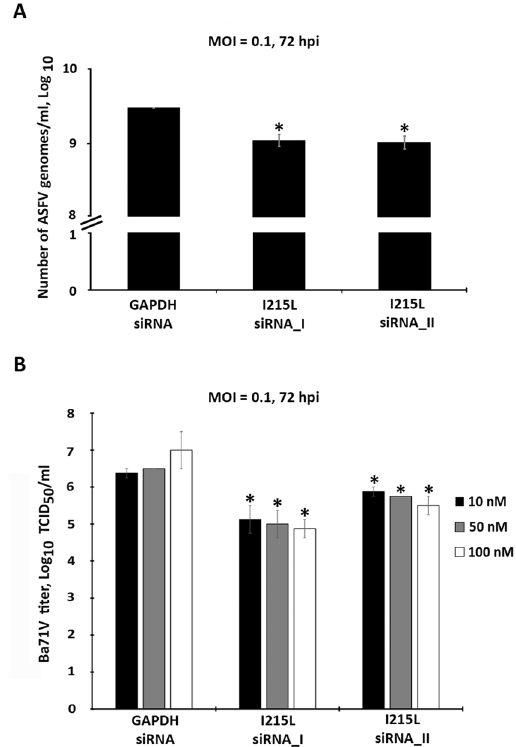
Figure 4. Knockdown of I215L mRNA levels inhibits ASFV DNA replication and progeny production. (A) I215L-depleted cells showed a decreased number of ASFV genomes [1.01 × 10 9 genomes/ml for siRNA_I sequence ( − 65.83%) and 1.09 × 10 9 genomes/ml for siRNA_II ( − 64.87%)] when compared to the control group (2.98 × 10 9 genomes/ml, p ≤ 0.05). Results represent the mean of three independent experiments. (B) A statistically significant reduction in viral yield was observed in ASFV-infected Vero cells (MOI of 0.1) transfected with siRNAs against ASFV-I215L (100 nM), in comparison with the GAPDH siRNA-transfected infected cells (between − 96.86% and − 99.24%; 1 × 10 4.88 and 1 × 10 5.50 versus 1 × 10 7.00 viral particles/ml; p ≤ 0.05), at 72 hpi. The virus yield of each supernatant was calculated from the average of three independent experiments. Error bars represent standard error (SE) of the mean